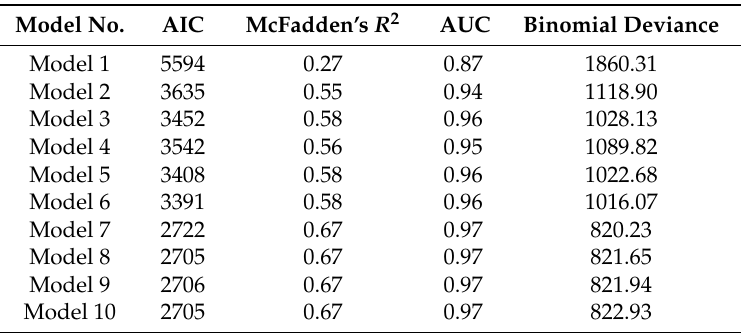
Table 2. Logistic regression model comparison. AIC: Akaike’s information criterion, AUC: area under curve.